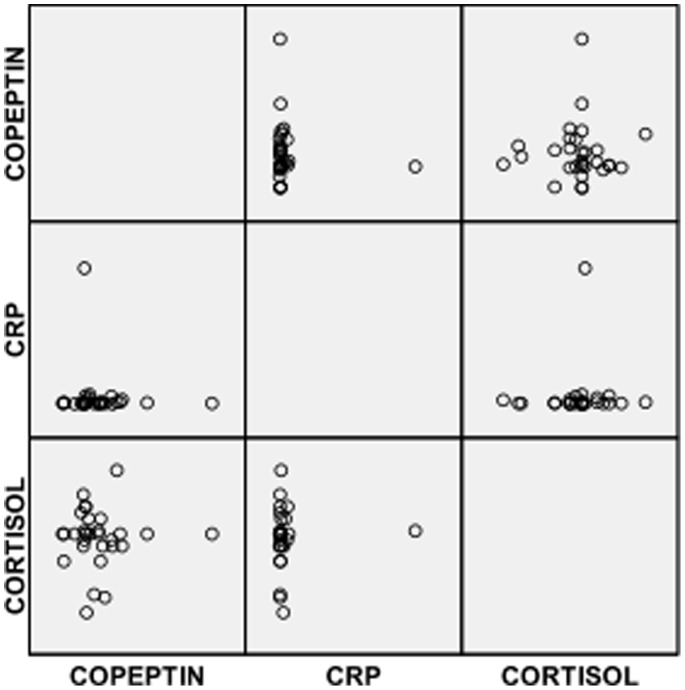
Scatter plots for CRP, copeptin and cortisol in control subjects.